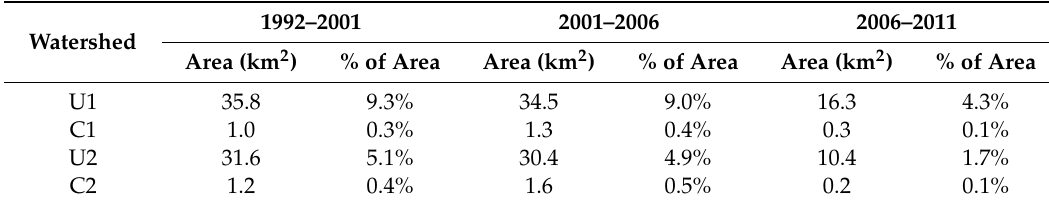
Table 2. Increase in urbanized area in each watershed over the three time periods covered by National Land Cover Database (NLCD) data.